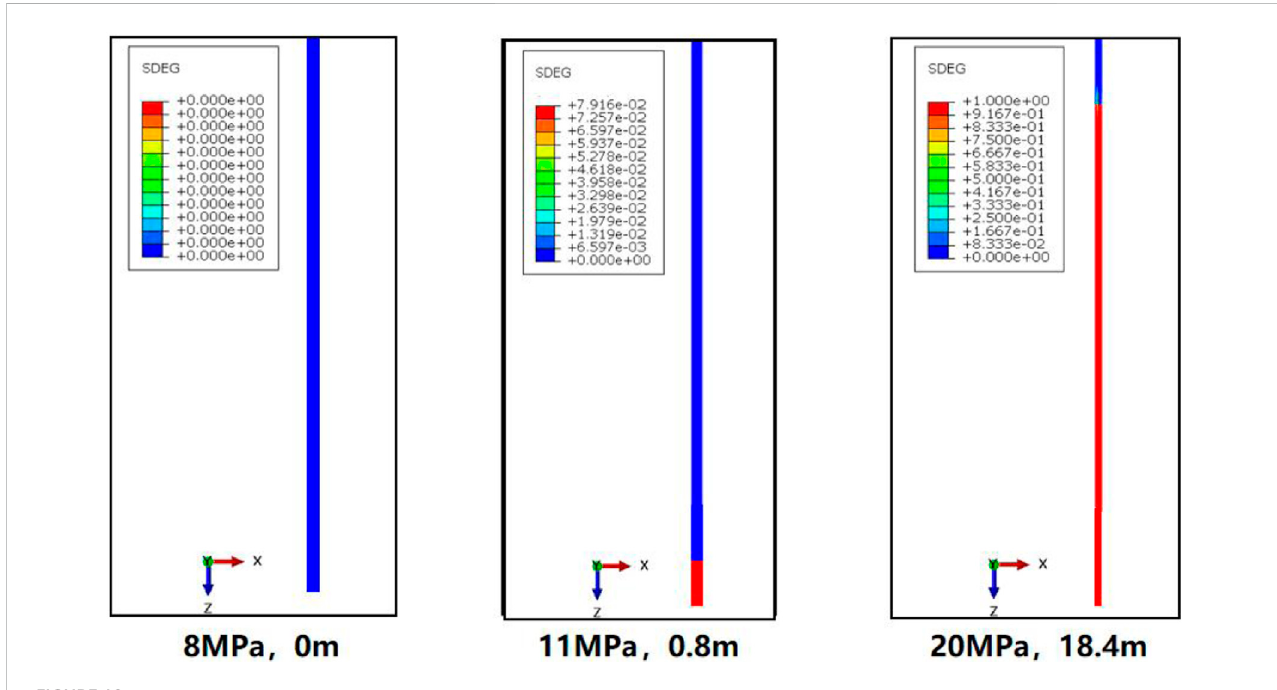
FIGURE 10 The stripping length varies with the gas storage